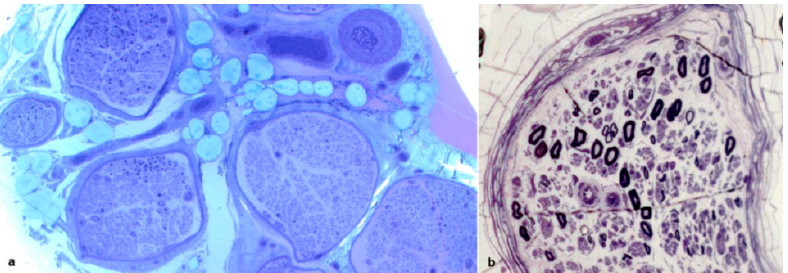
Figure 1. Sural nerve biopsies from hATTR patients. Semithin sections are stained with toluidine blue. ( a ) A biopsy from a 63 ‐ year ‐ old Val30Met patient showing a marked loss of myelinated fibers.